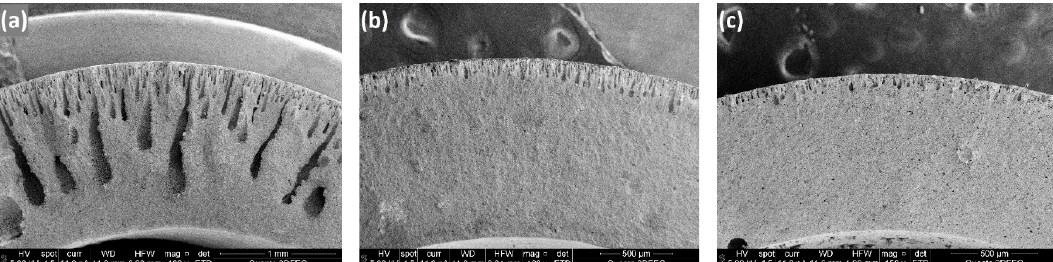
Figure 12. SEM images of MgO-CGO porous supports fabricated using ceramic powders with specific surface areas of ( a ) 12.53 m 2 /g, ( b ) 24.11 m 2 /g and ( c ) 26.33 m 2 /g.